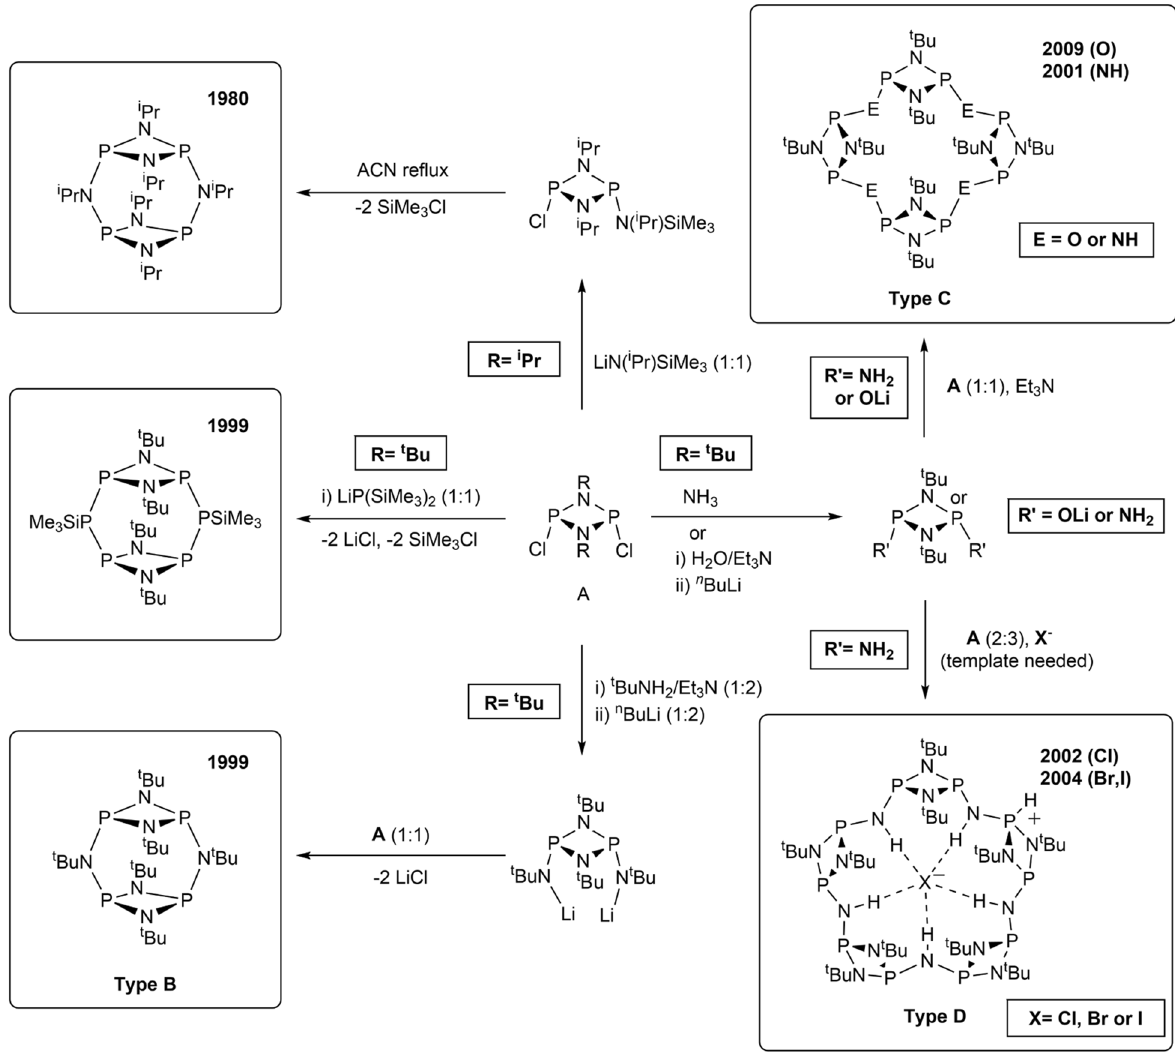
Fig. 1 Cyclodiphosph(III/II)azanes macrocycles previously reported. Synthetic routes to all-P III macrocyclic cyclodiphosphazanes dimeric (type B), tetrameric (Type C), and pentameric (Type D) species 13 – 22